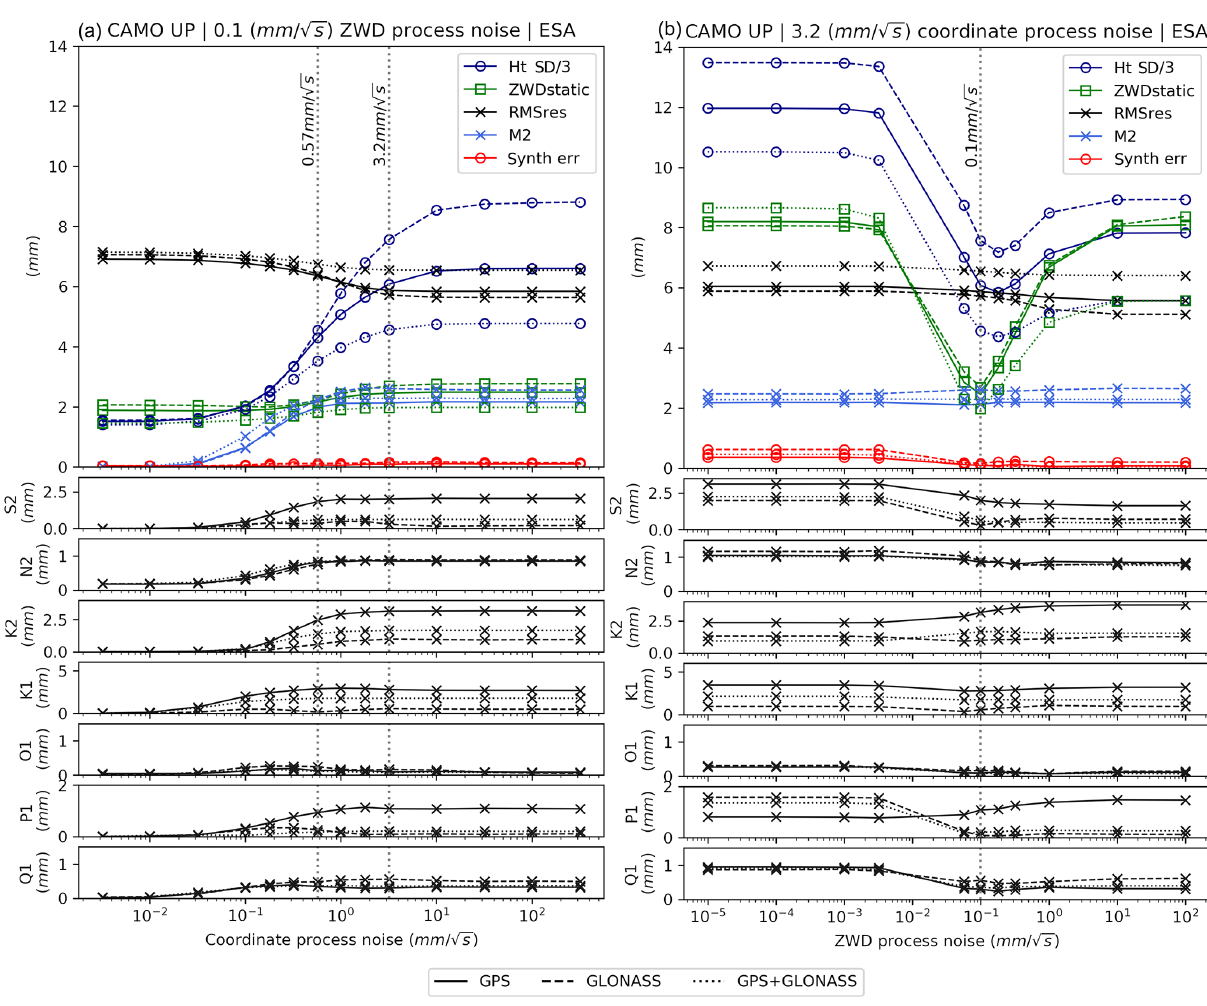
Figure 2. The effect of varying coordinate process noise (a) and zenith wet delay (ZWD) process noise (b) at test site CAMO for the up component (2010.0–2014.0), performed with ESA repro2 products. (cid:107) Z res (cid:107) is relative to FES2004_GBe. The different constellations’ configurations: GPS, GLONASS and GPS+GLONASS are presented as solid, dashed and dotted lines, respectively. The colours pertain to the different metrics as described in the text and legend (note the same scheme is used as per Penna et al., 2015).